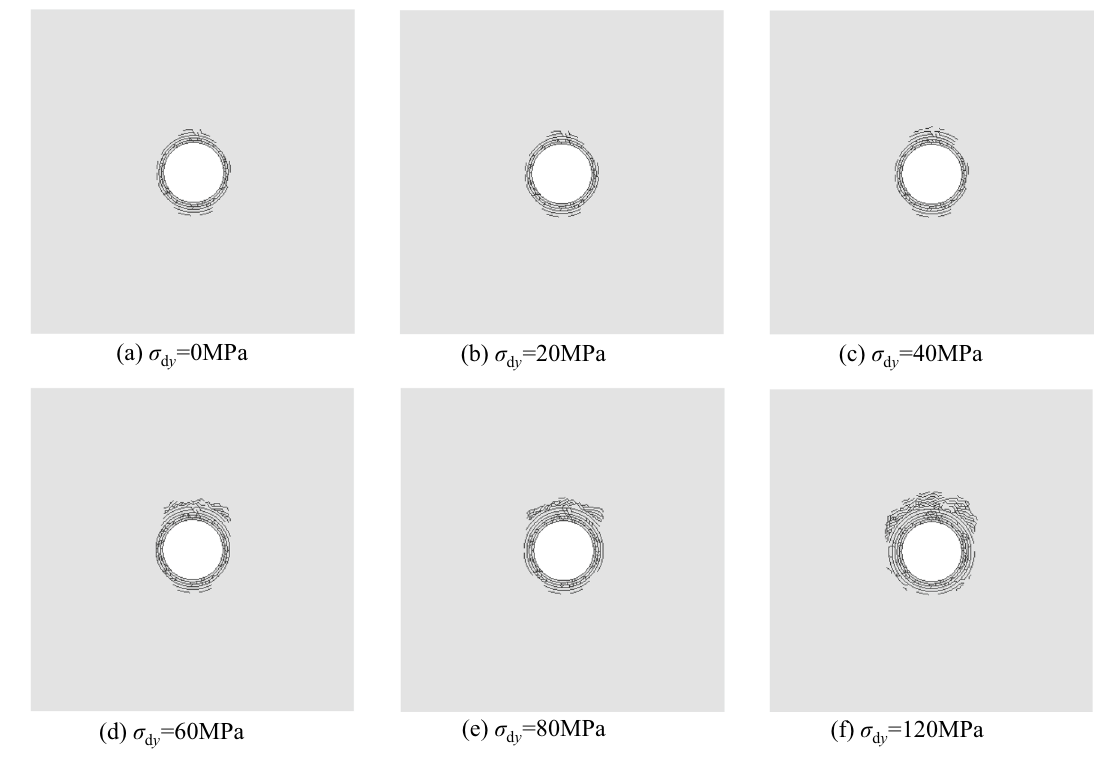
Fig. 9 Final failure modes of circular cavern subjected to various stress-wave amplitudes. Note: σ bances is generated from top